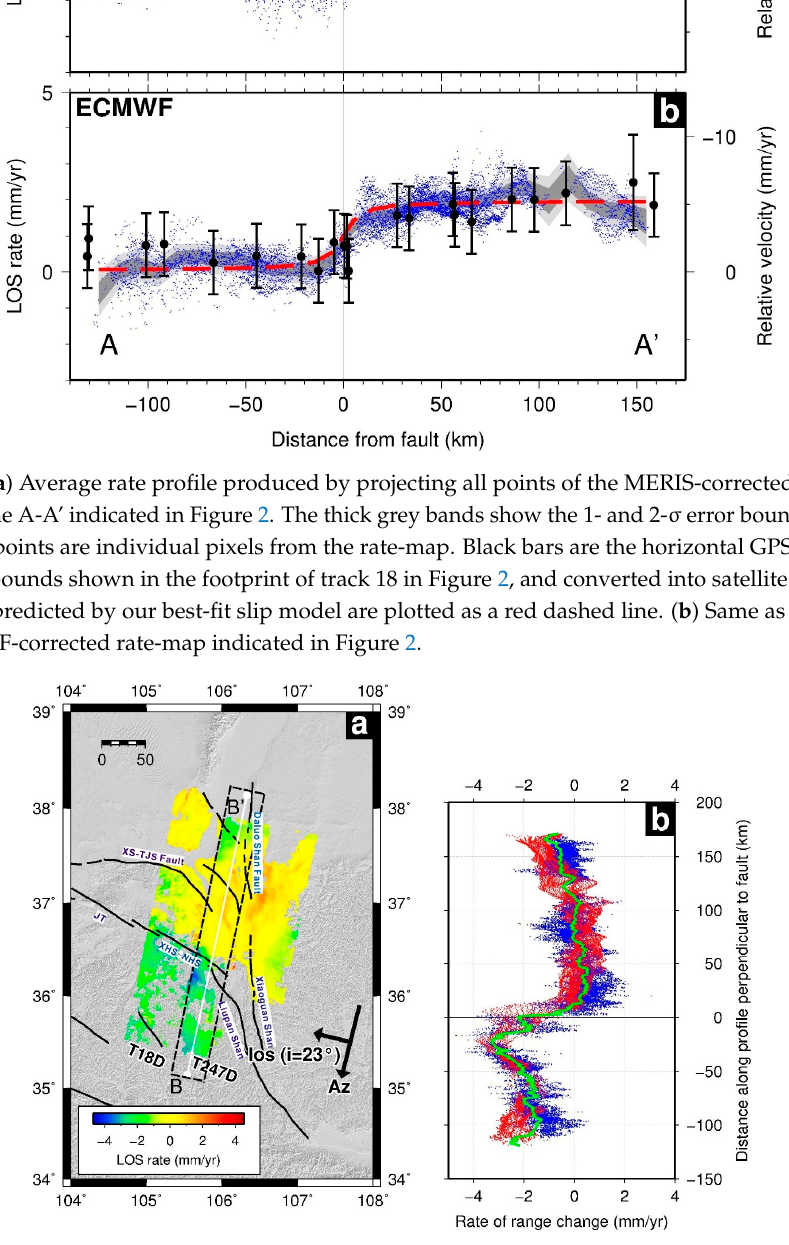
Figure 5. ( a ) Mean LOS ratemap for track 18 and 247, produced by stacking the MERIS-corrected and ECMWF-corrected interferograms respectively. The white line shows the profile centre for the profile presented in the right panel. The black dashed box shows the overlapping area between track 18 and 247. JT: Jing Tai fault, XHS-NHS: Xihua Shan-Nanhua Shan fault, XS-TJS: Xiang Shan-Tianjing Shan fault. ( b ) Rate profile for a 40 km-wide swath (black dashed box in the left panel) centered on the line B-B’. The blue points are individual pixels from the ratemap of track 18, red points from track 247, and the green line shows the mean velocity of the two datasets.